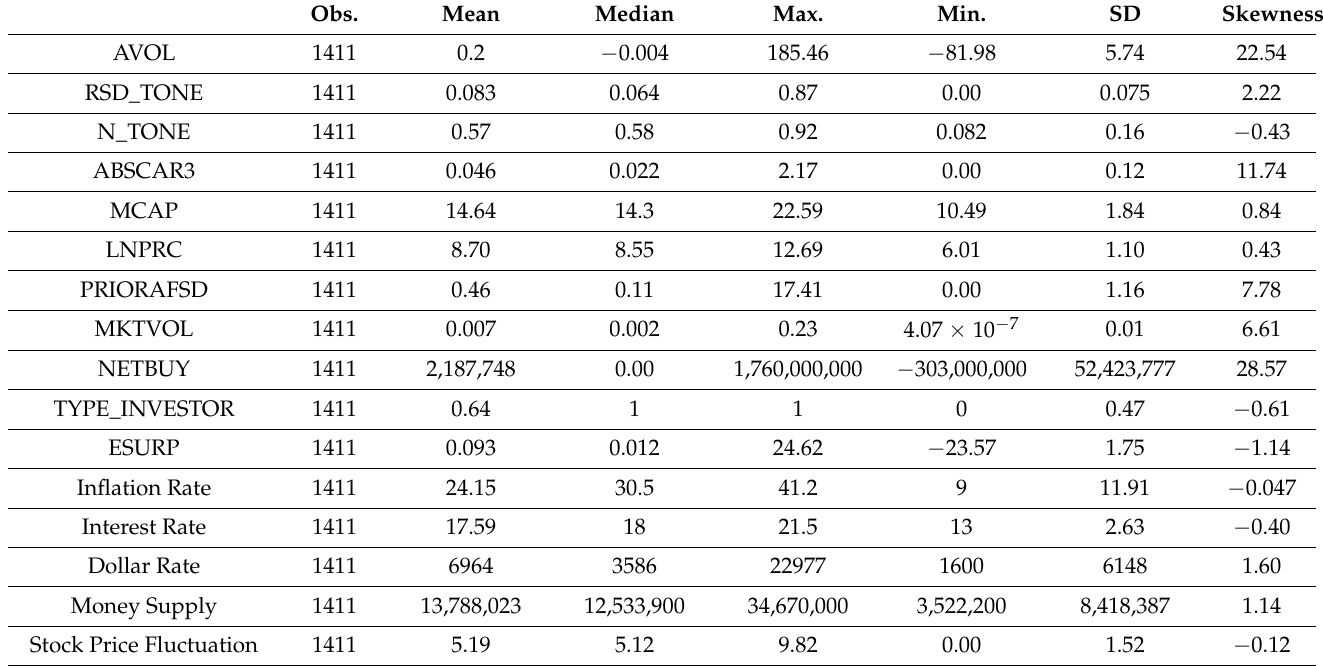
Table 3. Descriptive statistics of the